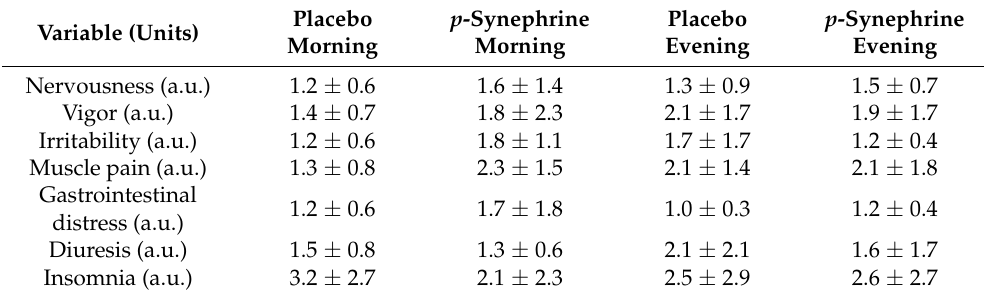
Table 2. Magnitude of side effects for the 24 h following the ingestion of 3 mg/kg of p -synephrine or a placebo in the morning (8:00 – 10:00 h) or evening (17:00 – 19:00 h) in women.